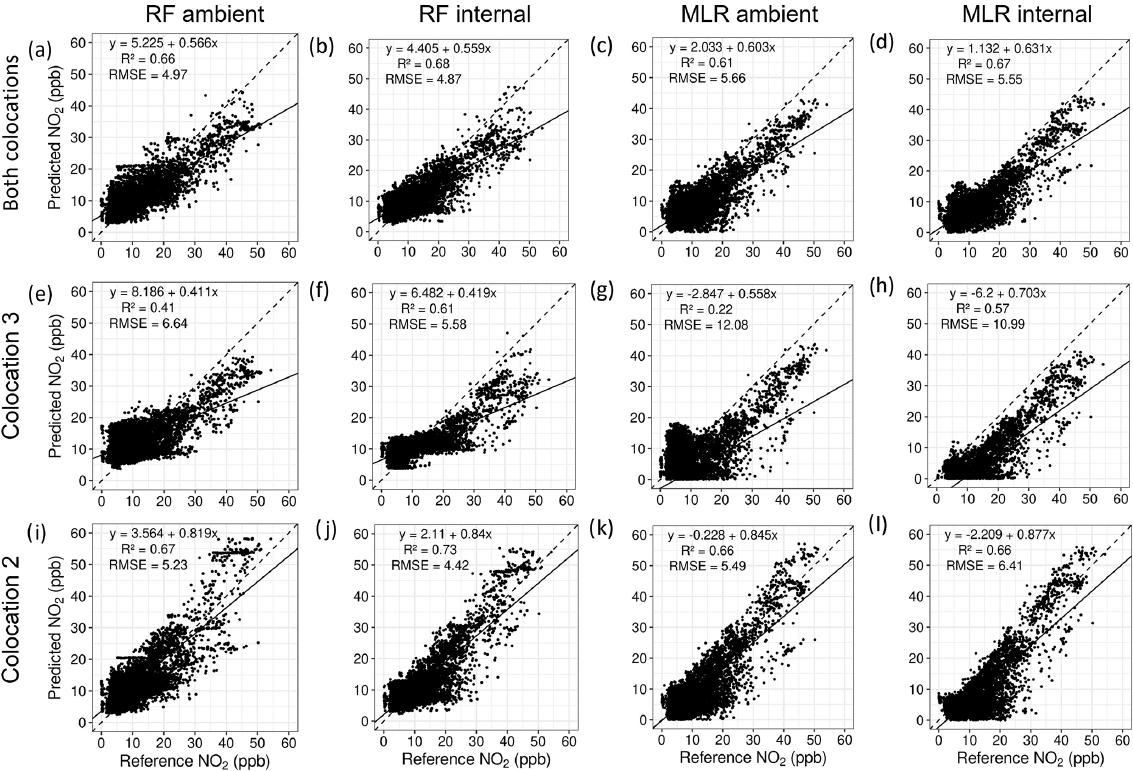
Figure 14. Scatter plots of predicted NO 2 versus reference NO 2 concentrations for the experimental data using MLR and RF models trained with co-location 2 (i–l) , co-location 3 (e–h) , and both combined (a–d) . All concentrations are reported in parts per billion.